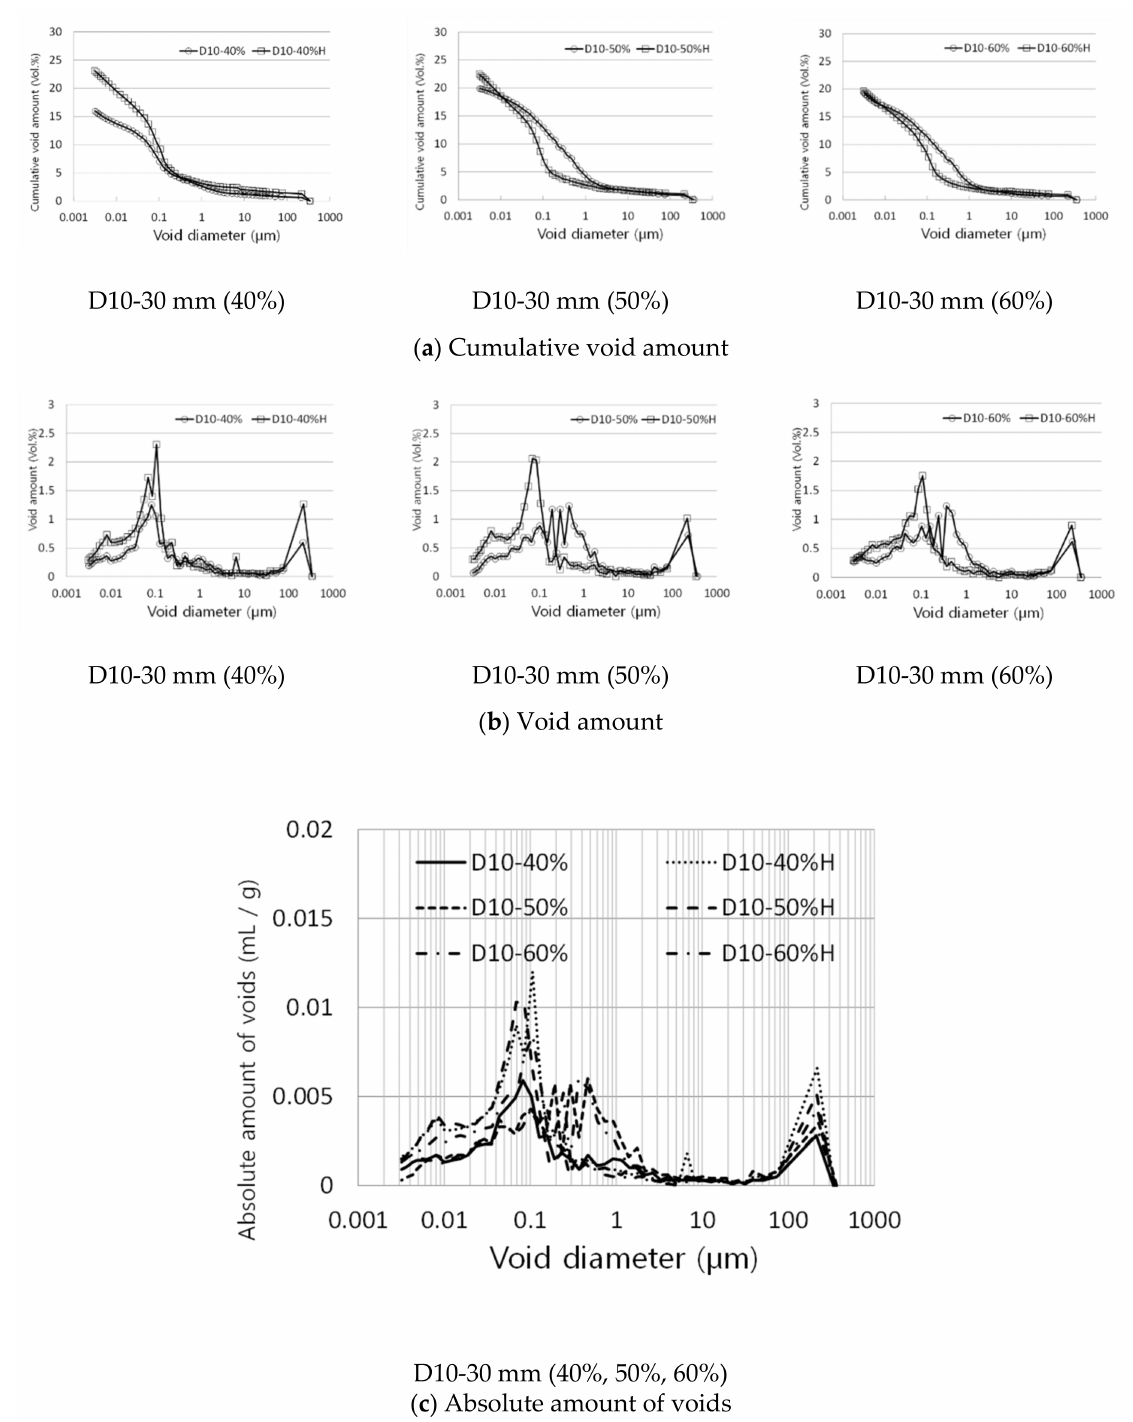
Figure 10. Variation of single reinforced concrete gap structure due to induction heating in accordance with void diameter and amount